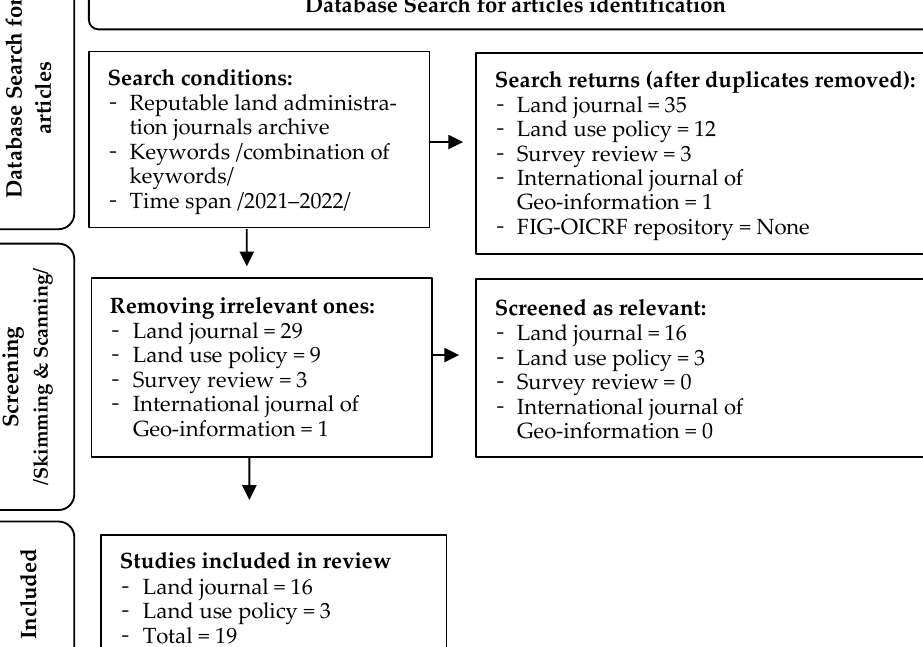
Figure 2. Literature identification flow-diagram